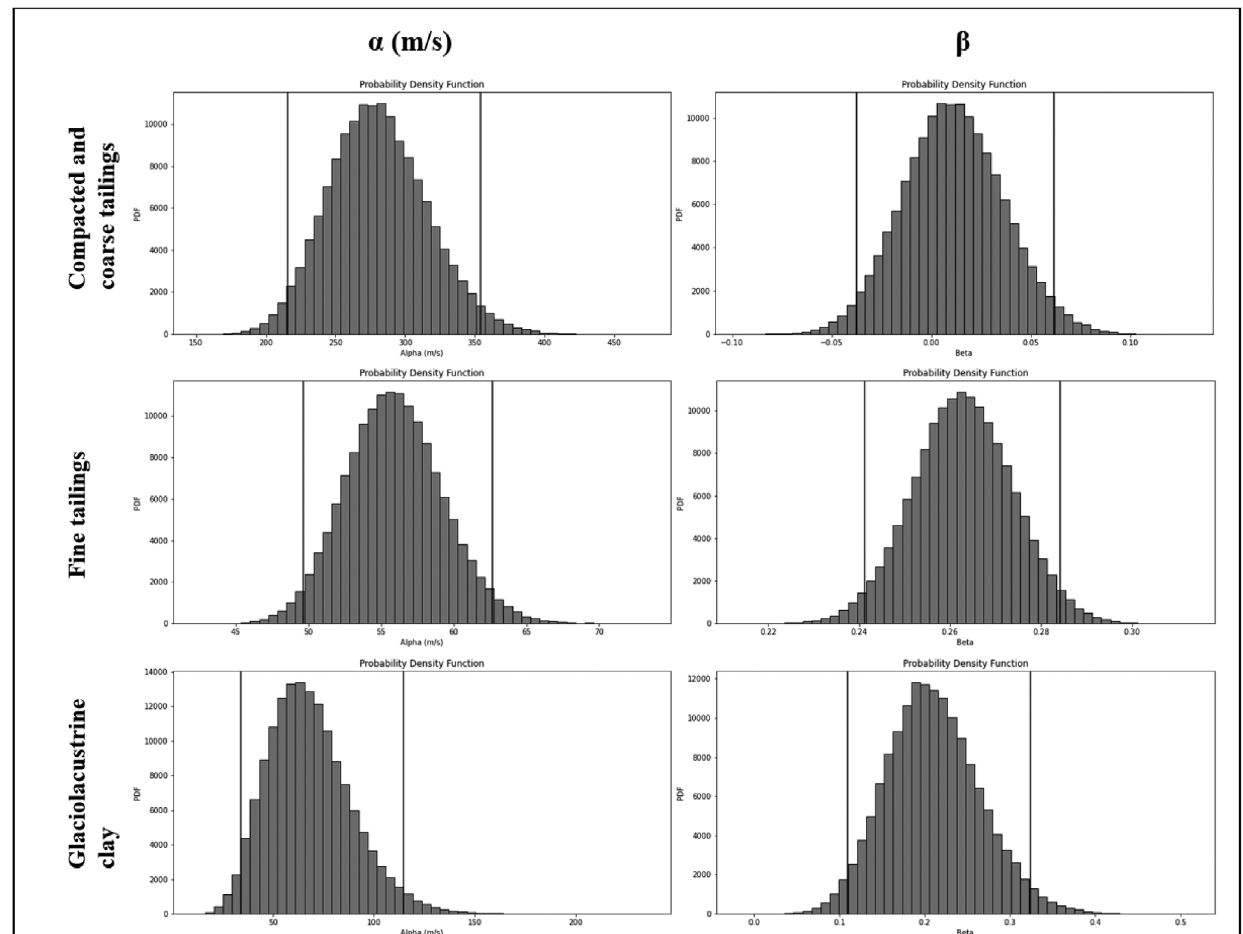
Fig. 7 Probability density functions of α and β parameters for each unit obtained from bootstrap sampling. Bootstrap sampling (150,000 samples) for each unit (compacted and coarse tailings, fi ne tailings and glaciolacustrine clay) was completed to obtain probability density functions of the α and β parameters. Black vertical lines are used to indicate the 95% con fi dence